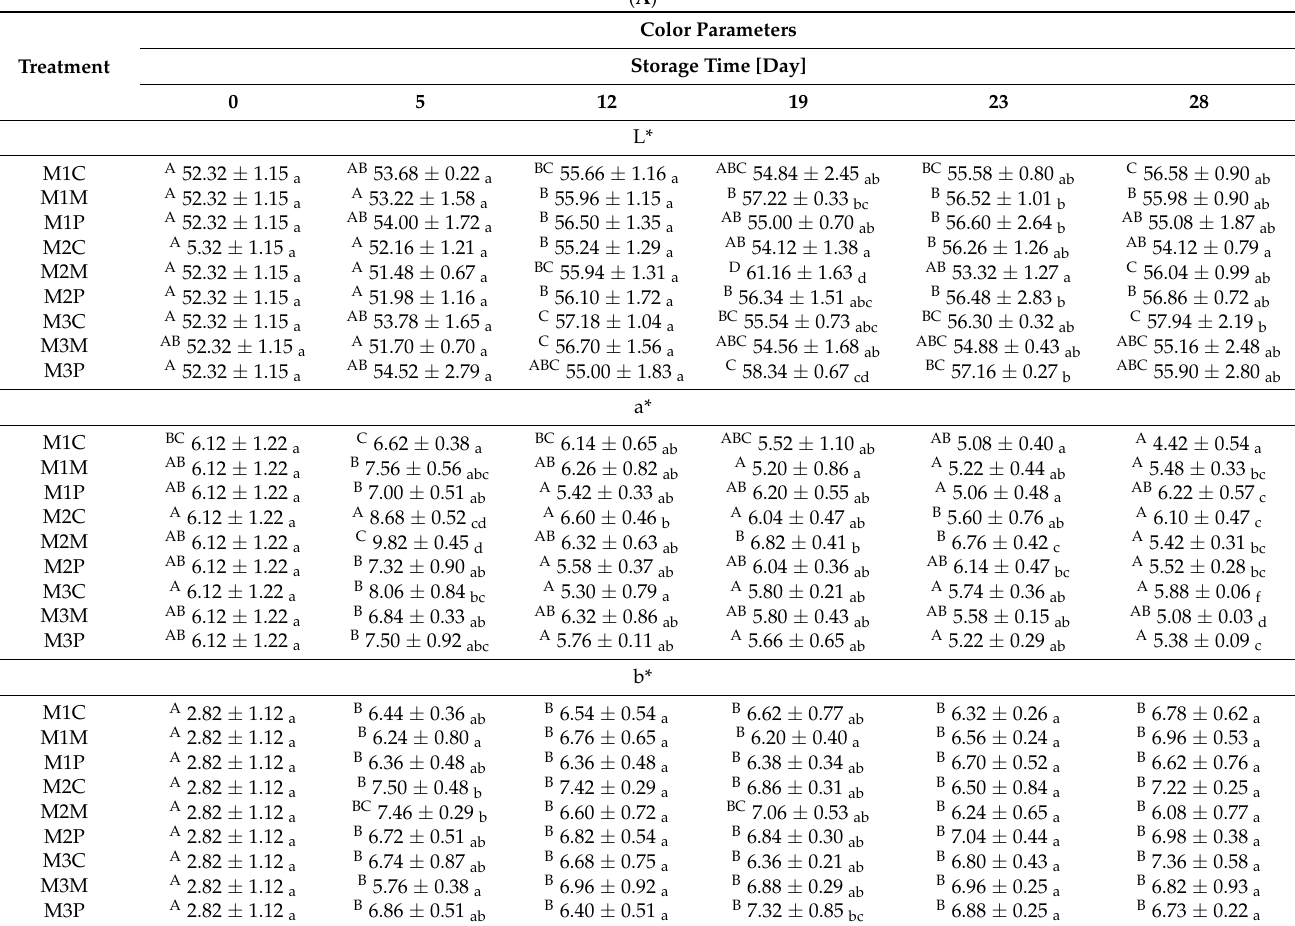
O 2 :CO 2 , C—control, M—monomer, P—modified